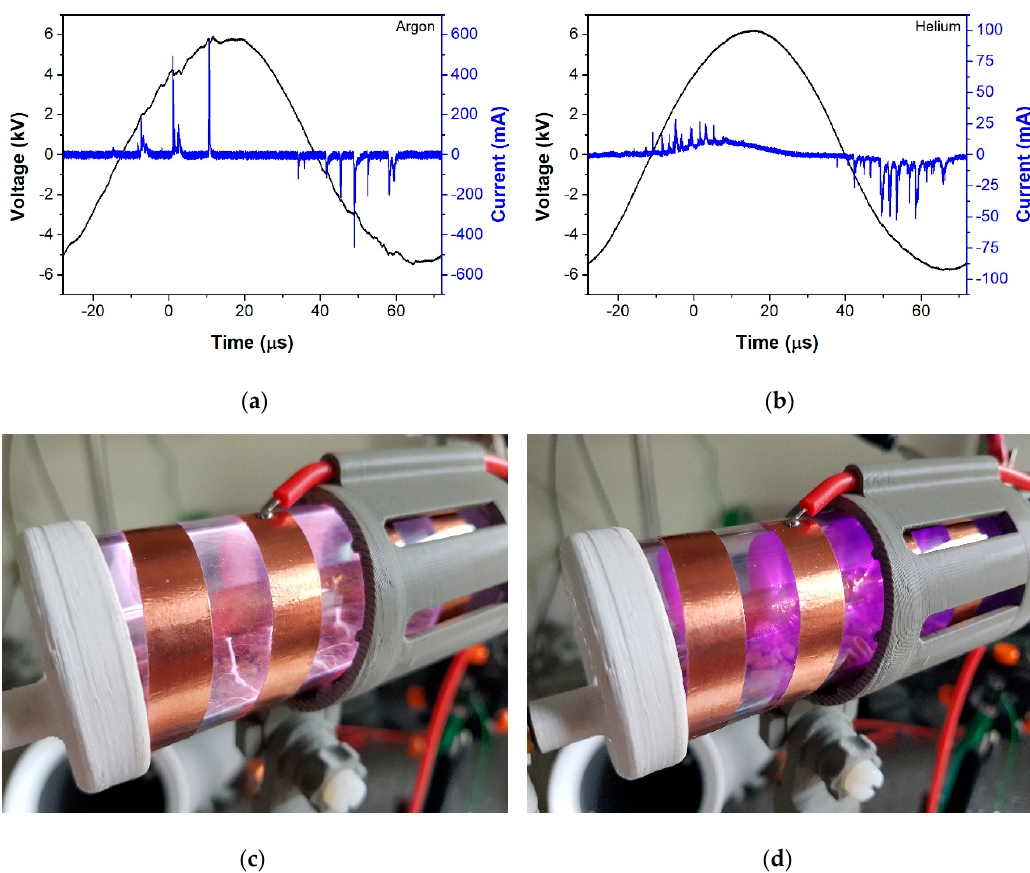
Figure 2. Current and voltage waveforms of the discharges generated in ( a ) argon and ( b ) helium along with pictures of the discharges in ( c ) argon and ( d ) helium.